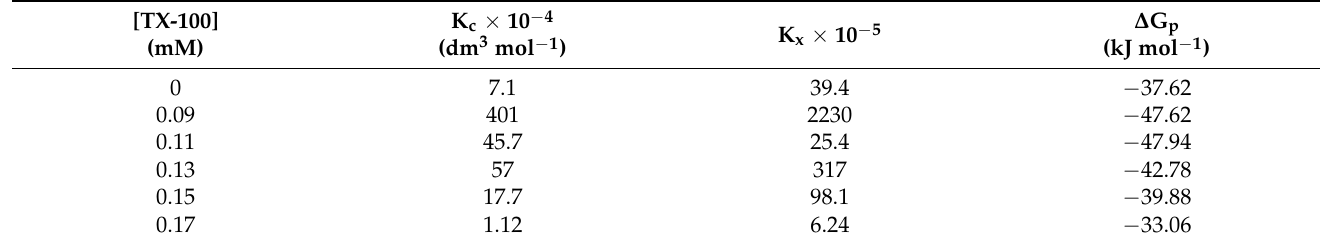
Table 2. Gibbs energy of partition ∆ G p , partition coefficient, K x partition constant, K c , for NGB/CPC systems at various Triton X-100 concentrations.